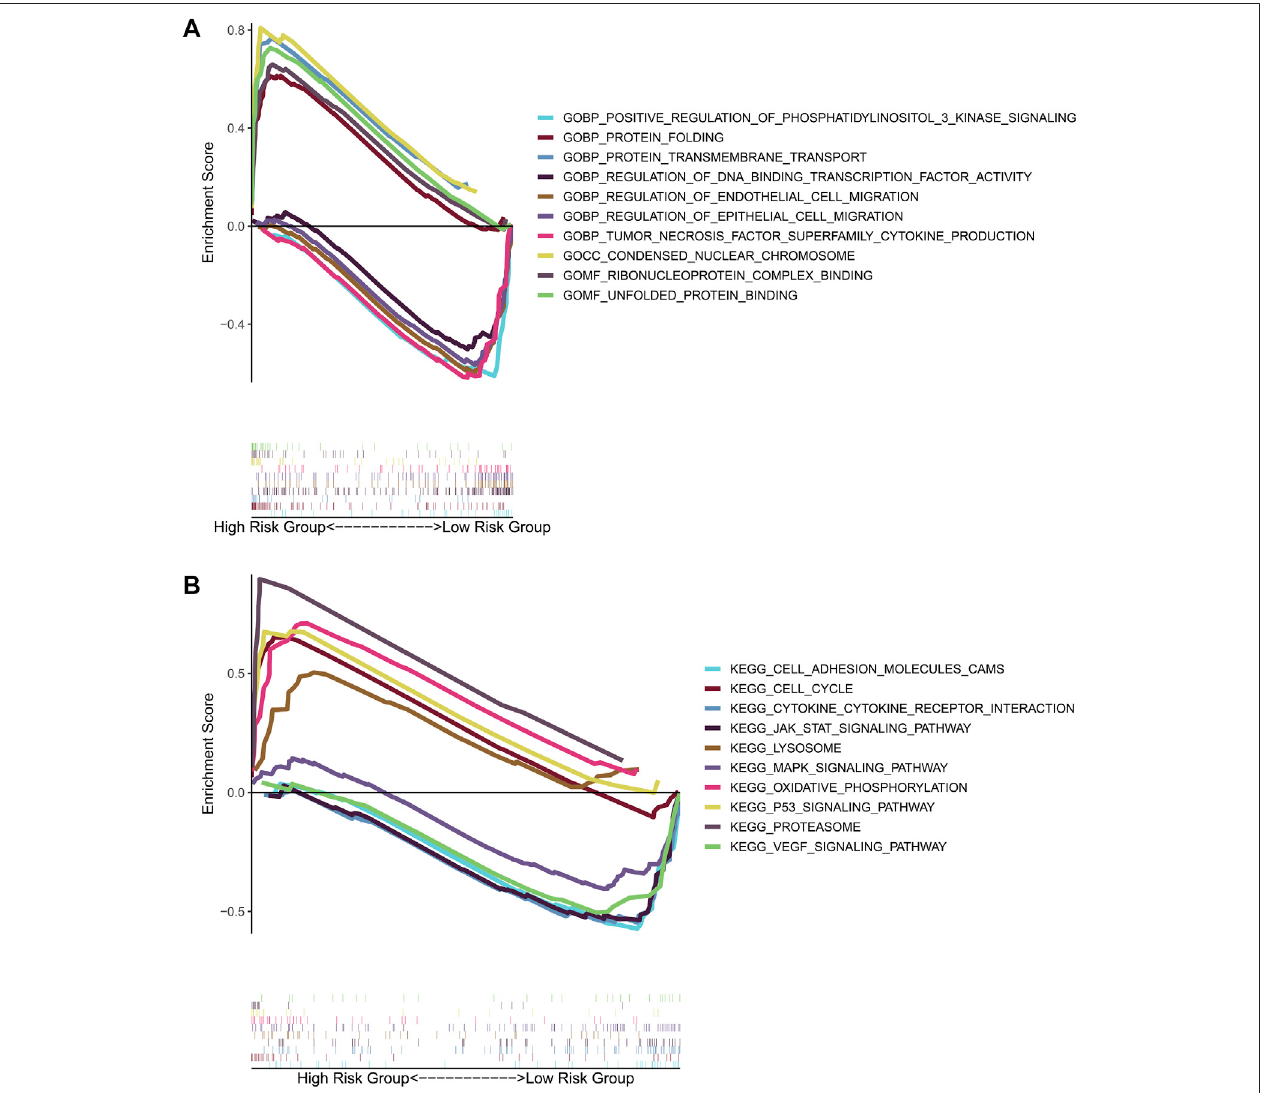
FIGURE10| GSEAforthegeneprognosticsignature. (A) Thesigni fi cantenrichmentofthetop5tumor-relatedGOtermsinhigh-riskgroupandlow-riskgroup. (B) The signi fi cant enrichment of the top 5 tumor-related pathways in high-risk group and low-risk group.